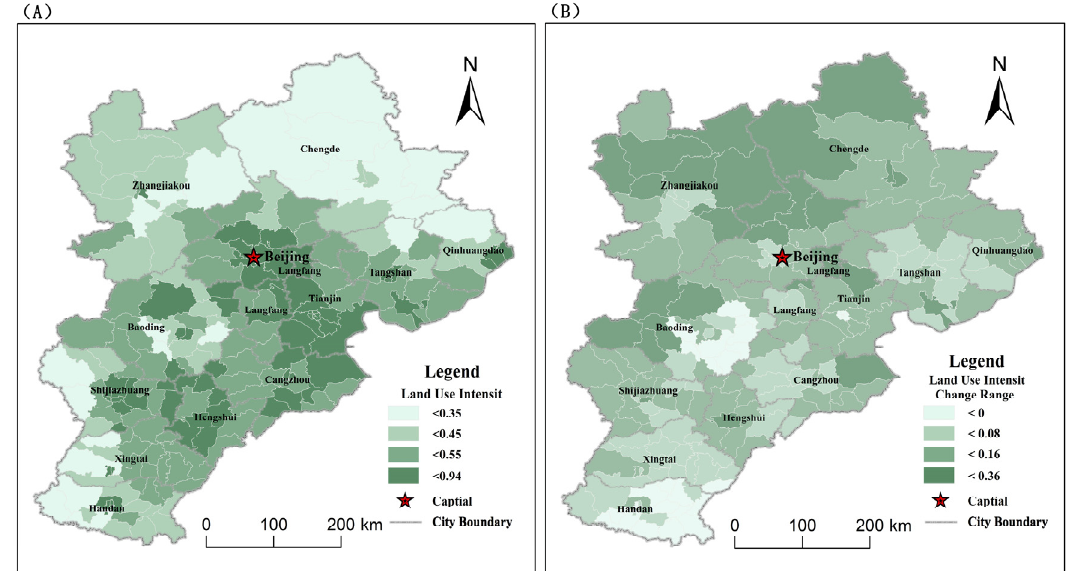
Figure 3. ( A ) Spatial distribution of land use intensity in the BTH urban agglomeration in 2015; ( B ) Spatial distribution of the change rate of land use intensity in the BTH urban agglomeration from 2010 to 2015.